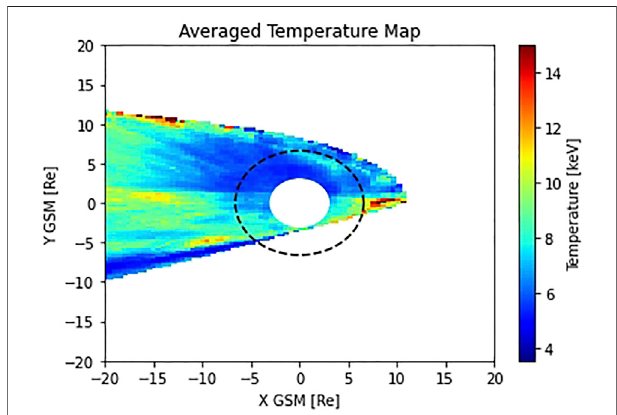
FIGURE 7 | Average temperature map for the entire storm interval, 8:00 – 13:30 UT. The white disk has a radius of 3 Re centered on Earth, while the dashed circle indicates geosynchronous orbit. The color bar limit goes up onlyto15 keV,asopposedto25